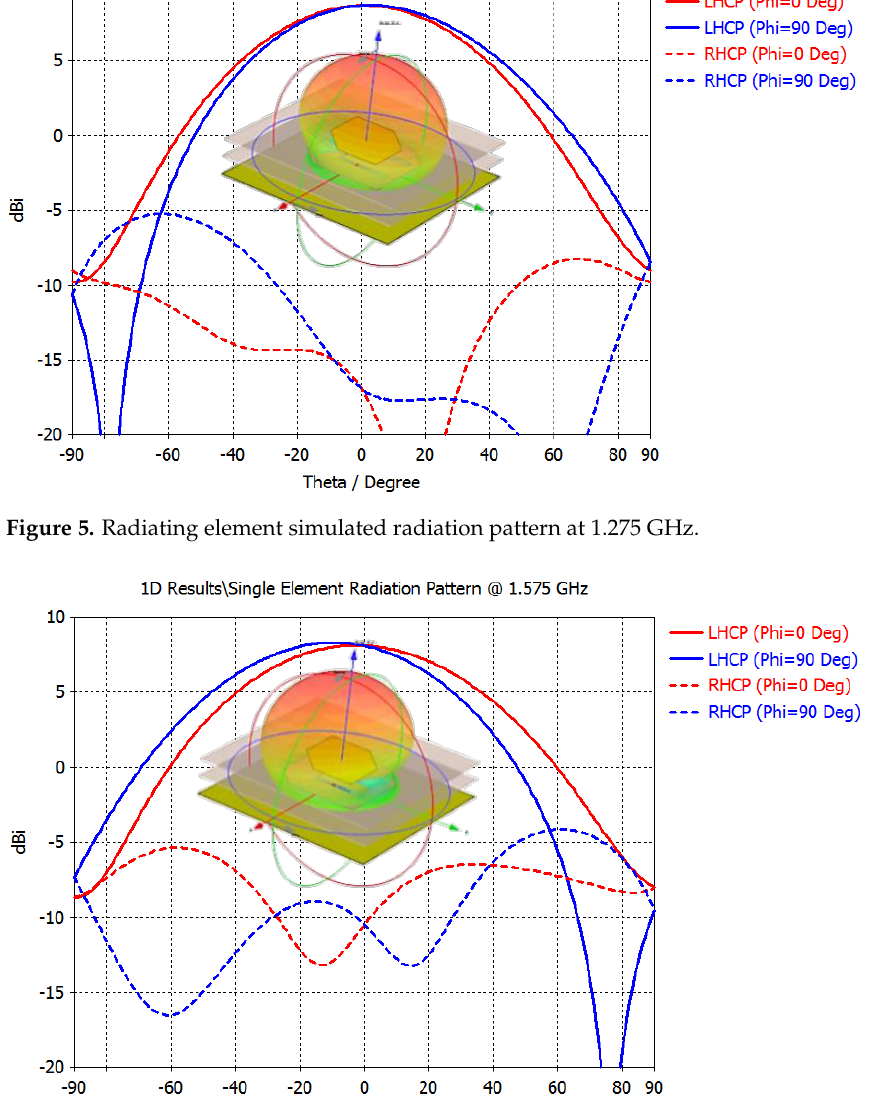
Figure 6. Radiating element simulated radiation pattern at 1.575 GHz.